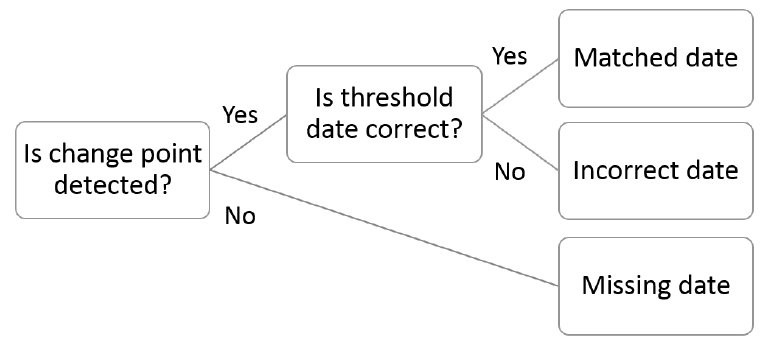
Figure 6. Classification of results